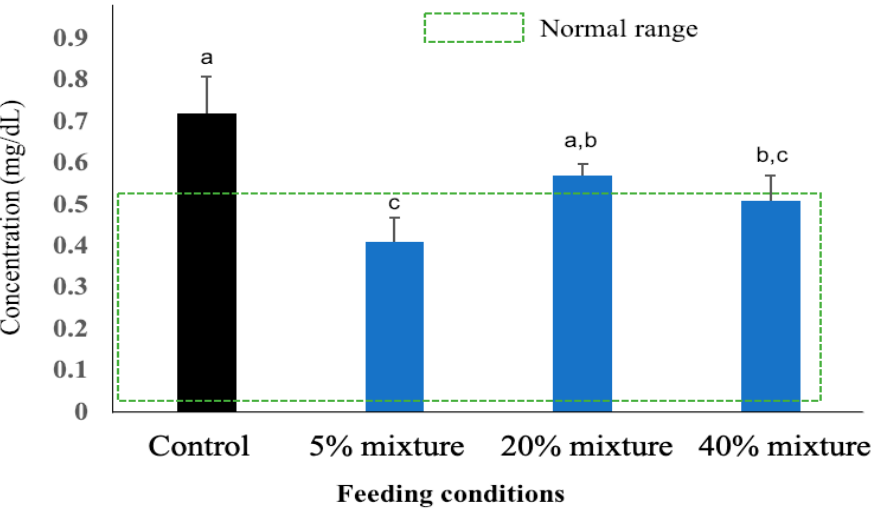
Figure 5. The plasma CRP level of pigs of all four study groups at 17 weeks of age. Results presented are the mean ± SD of three independent experiments. Different letters upon the bars indicate significant difference at 5% ( p < 0.05) level while same letters indicate no significance difference when compared two bars.